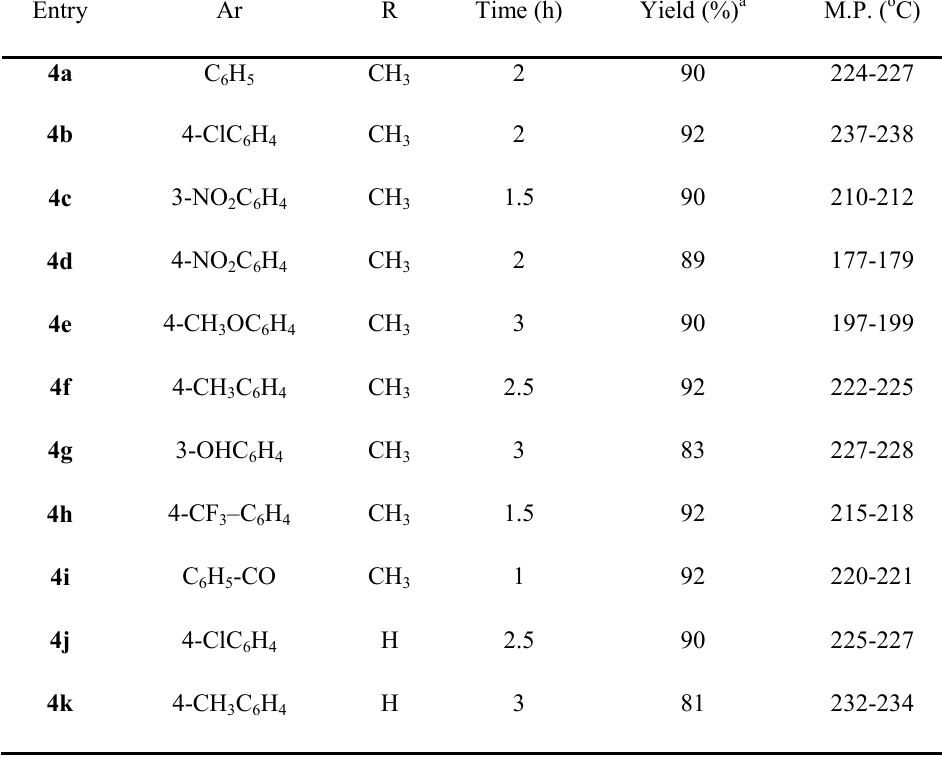
Table 2. Synthesis of 4 H -benzo[ b ]pyrane derivatives in the presence of KF-alumina in ethanol at reflux